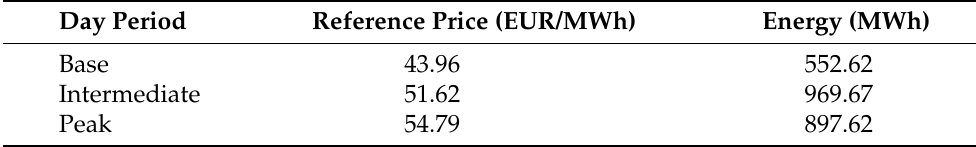
Table 2. Reference price and energy for the negotiating parties (customer and